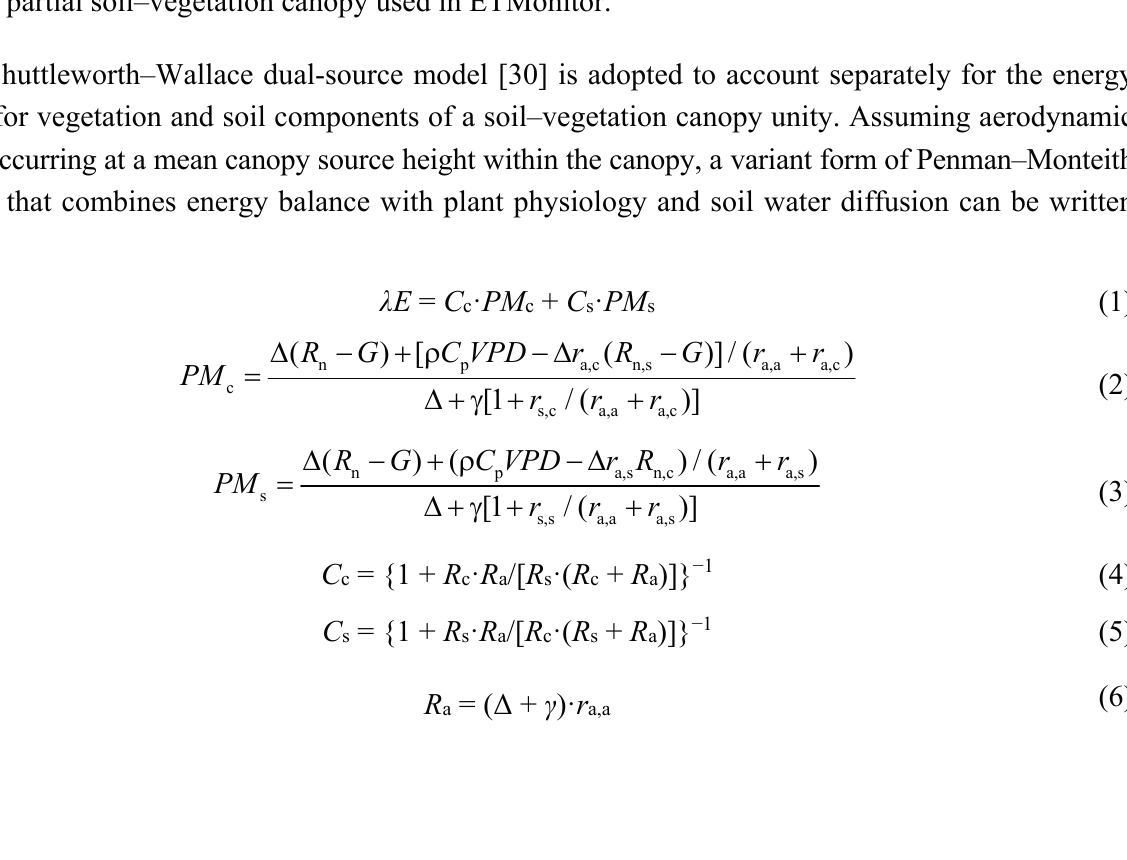
Figure 3. Schematic description of the latent heat flux partitioning with the relevant resistances for partial soil–vegetation canopy used in